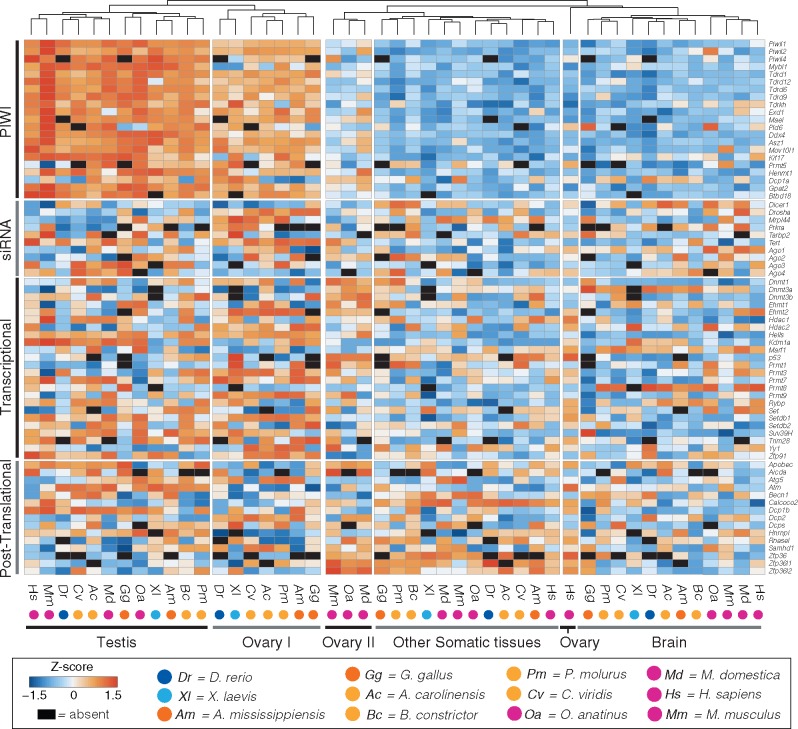
—Hierarchical clustering Z-score heatmap of TE regulatory genes in germline and somatic vertebrate tissues. Analysis of differential expression of a subset of key conserved genes (present in at least eight species) involved in TE silencing suggests the existence of five main expression profiles across vertebrate tissues: vertebrate testis, characterized by the highest activation status of the PIWI:piRNA pathway and transcriptional regulators; ovary of nonmammal species, with expression patterns similar to the testis; mammalian ovary (to the exclusion of humans), which shows a sharp decreased expression of PIWI genes; other somatic tissues (average Z-scores across heart, kidney, liver, muscle, spleen, and small intestine after individual tissue heatmap supported the existence of a single cluster); and vertebrate brain.